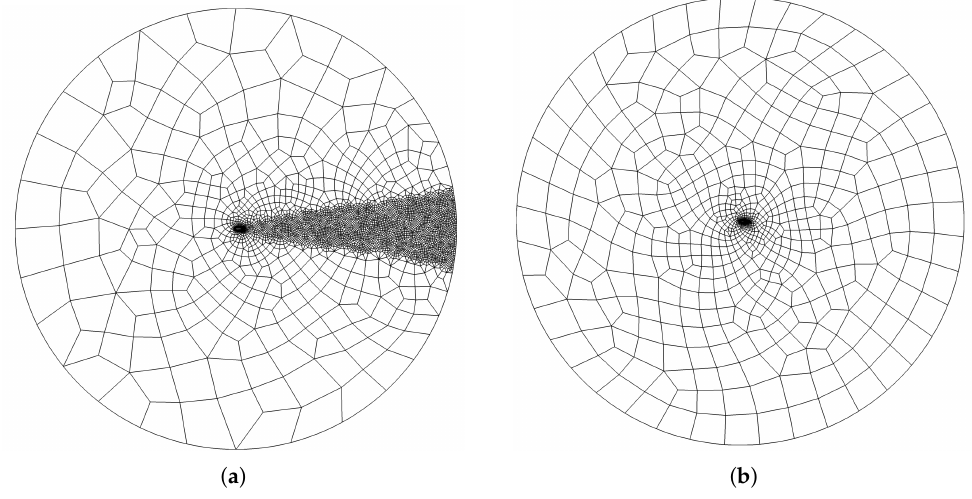
Figure 2. Mesh of NACA0012 ( a ) and SD7003 ( b